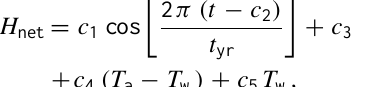
Fig. 2. Seasonal evolution of the dimensionless thickness δ of the surface well-mixed layer for the general case of a dimictic lake.